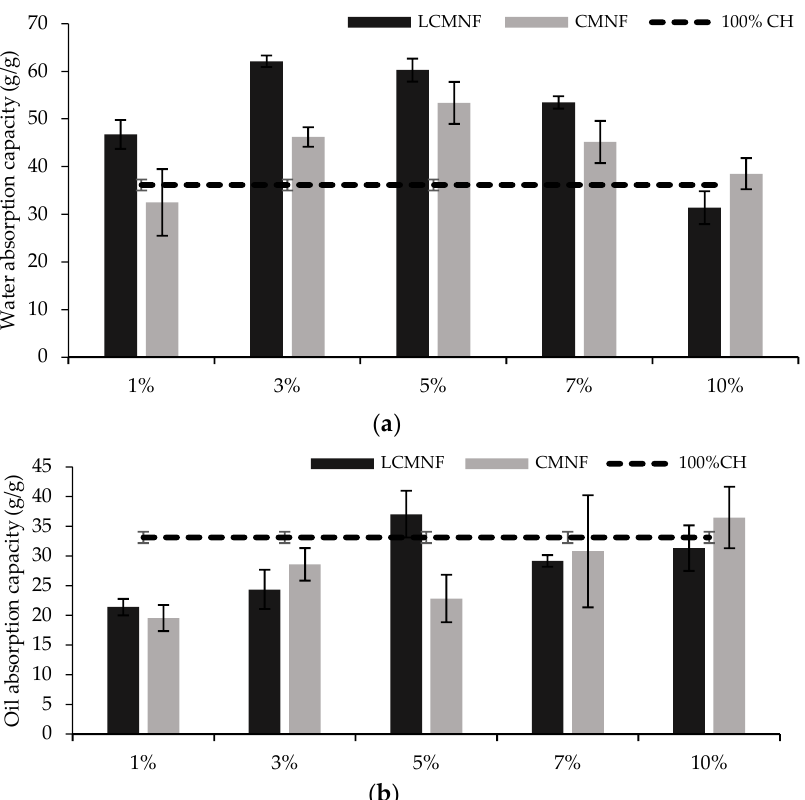
Figure 3. ( a ) Water and ( b ) soybean oil absorption capacity of LCMNF-CH and CMNF-CH aerogels. Bars with different letters are significantly different ( p ≤ 0 .05).